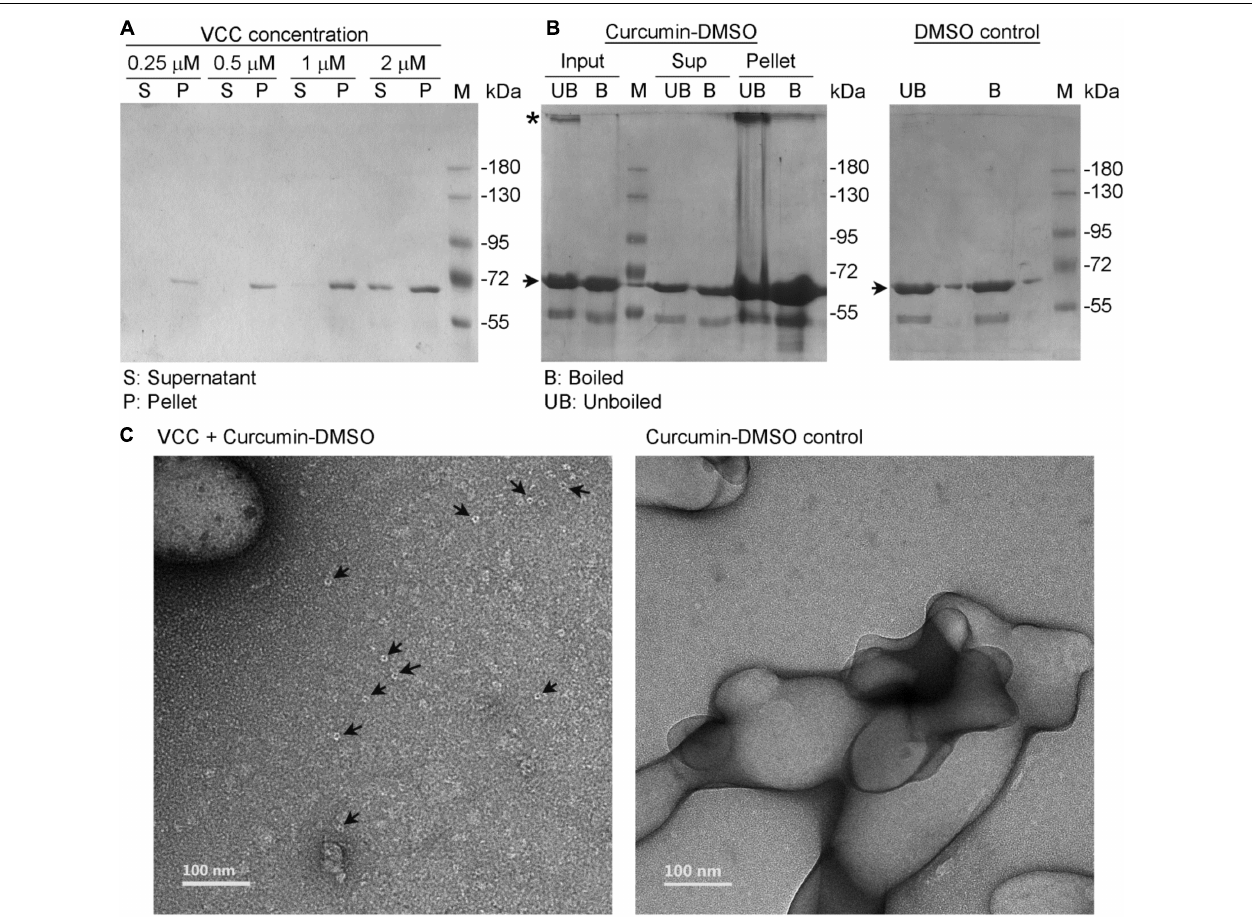
FIGURE 3 | Vibrio cholerae cytolysin tends to associate with the insoluble fraction of curcumin and forms SDS-stable oligomers. (A) Curcumin, from a stock solution prepared in DMSO, was added to VCC (at four different concentrations; 0.25, 0.5, 1, and 2 µ M) in the aqueous buffer in PBS. The final concentration of curcumin in the reaction mixture was adjusted to 500 µ g/ml. Association of VCC with the insoluble fraction of curcumin, generated upon exposure to the aqueous environment, was probed by the pull down-based assay, in which pellet and the supernatant fractions were analyzed by SDS-PAGE and Coomassie staining. (B) Curcumin, from a stock solution prepared in DMSO, was added to VCC (4 µ M) in the aqueous buffer in PBS, and the final concentration of curcumin was adjusted to 500 µ g/ml. SDS-stable oligomer formation by VCC associated with the insoluble fraction of curcumin was probed by pull down-based assay, in which the pellet and the supernatant fractions were analyzed by SDS-PAGE and Coomassie staining, with or without boiling in the SDS-PAGE sample buffer. Unboiled fractions allowed detection of the SDS-stable oligomer formation by VCC, if any. For a control reaction, equivalent volume of DMSO, lacking curcumin, was also added to VCC (right panel). The bands corresponding to the monomeric and oligomeric form of VCC are indicated with arrow and asterisk, respectively. Lanes marked as M show the protein molecular weight markers. Data shown here are the representatives of three independent experiments. (C) TEM-based imaging showed formation of some ring-like structure by VCC (indicated with arrow) upon association with the insoluble fraction of curcumin (left panel). Such structures were not documented in the curcumin control without VCC (right